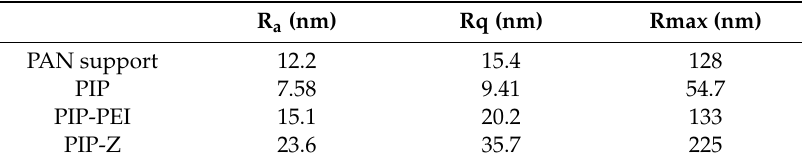
Table 3. Value as obtained from AFM image analysis.